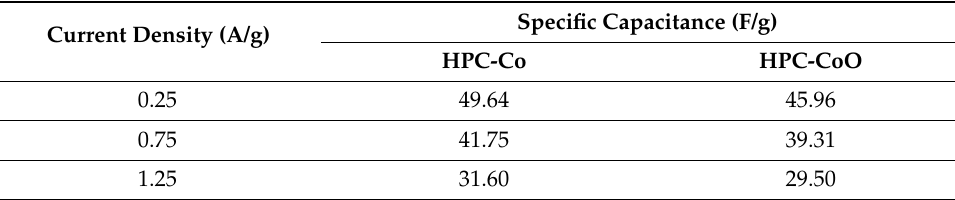
Table 2. Specific capacitance at different current